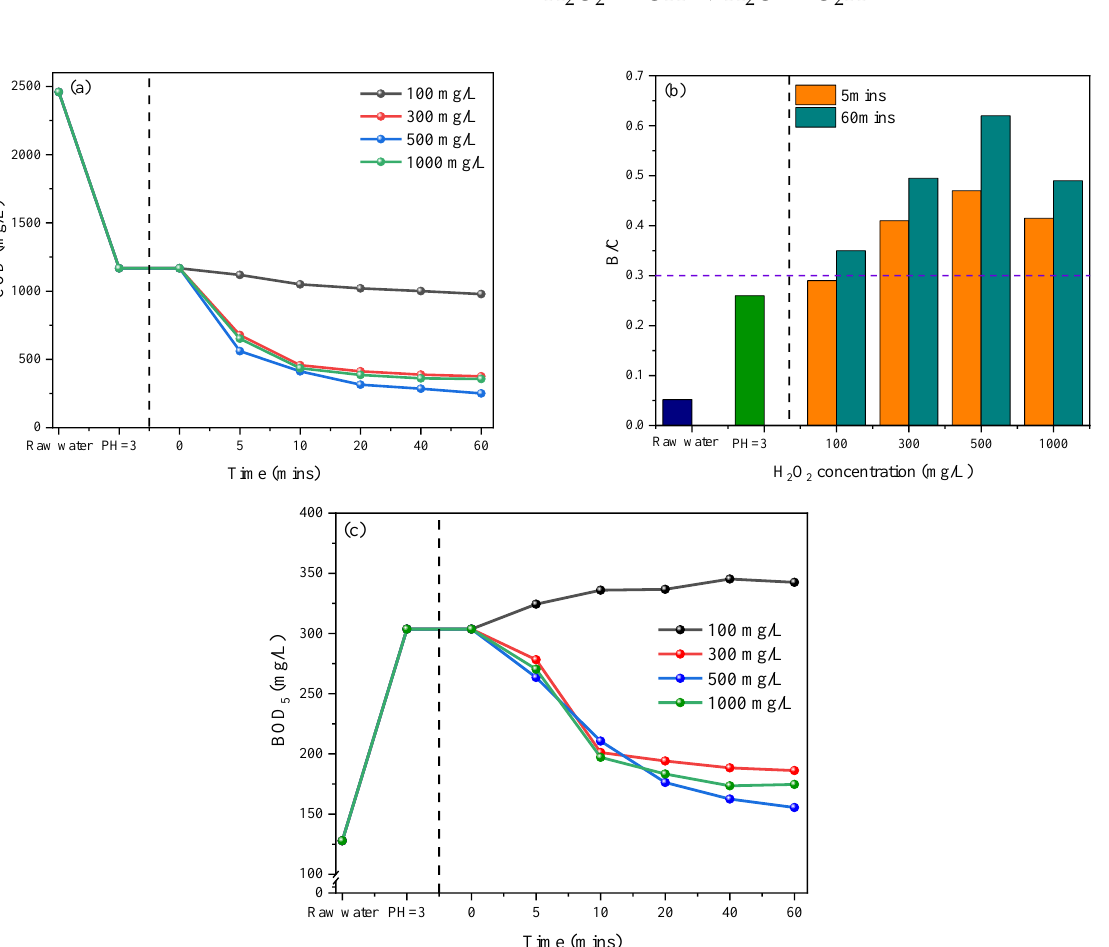
Figure 2. Effect of H 2 O 2 concentration on ( a ) COD removal; ( b ) B/C values; ( c ) BOD 5 variation during Fenton oxidation. Conditions are as follows: Fe 2+ concentration 120 mg/L; 250 mL wastewater; pH = 3.0.